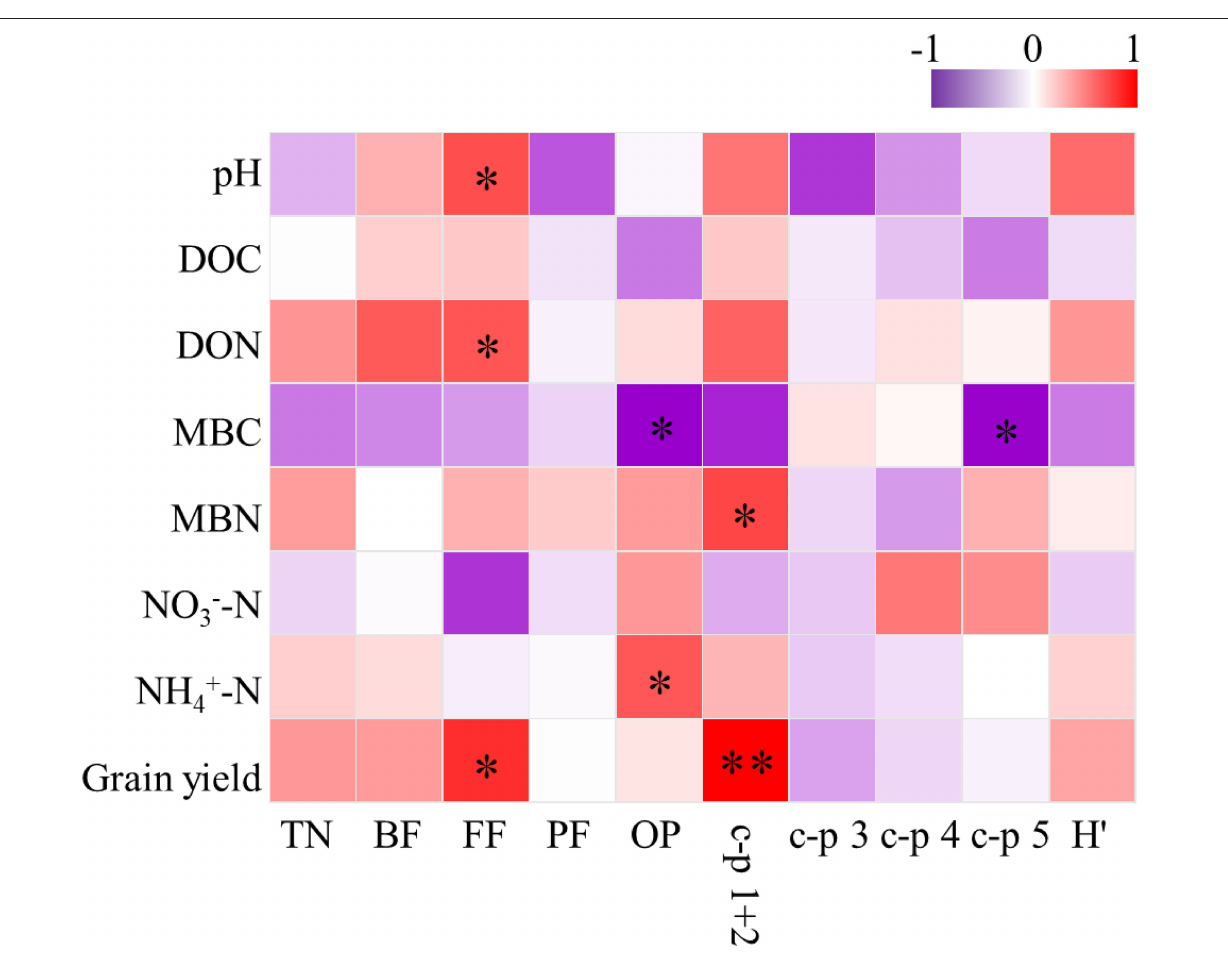
FIGURE 4 | Correlations between soil properties, grain yield and soil nematode community under elevated ozone. DOC, dissolved organic carbon; DON, dissolved organic nitrogen; MBC, microbial biomass carbon; MBN, microbial biomass nitrogen; TN, total nematodes; BF, bacterivores; FF, fungivores; PF, plant parasites; OP, omnivorous-predatory; H ′ , Shannon-Wiener diversity index. * The asterisk represents a significant correlation at the 0.05 probability